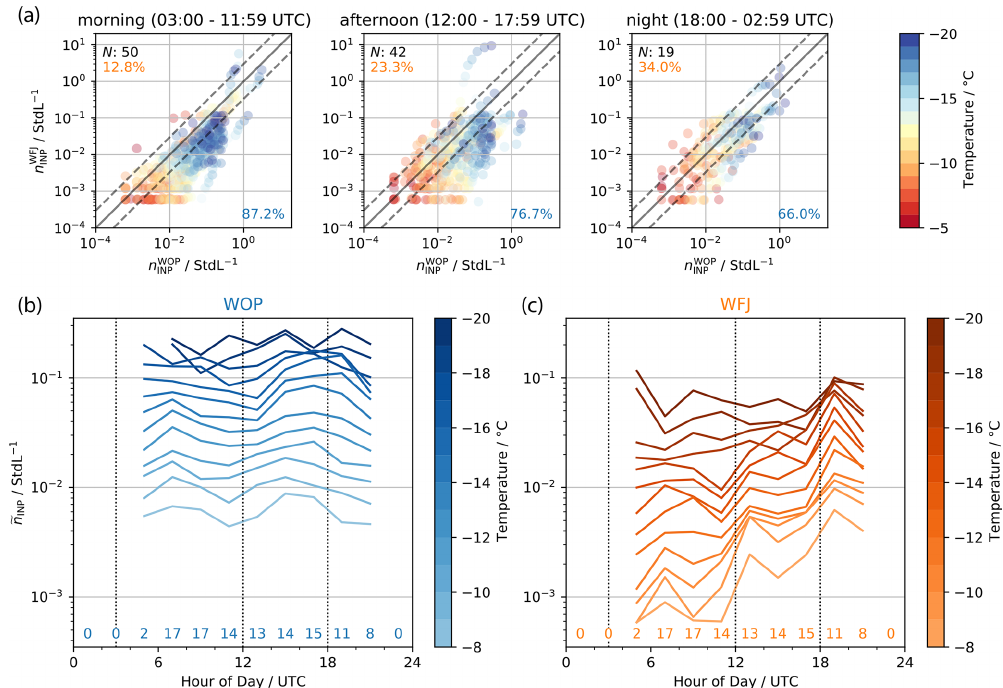
Figure 4. (a) Scatterplots of INP samples taken in parallel on the mountaintop (WFJ) and high valley (WOP) site in the morning, afternoon, and at night. Samples were considered to be in parallel when their sample time differed by less than 30min. The color indicates the activation temperature of a given pair of INP concentrations. The solid line represents the 1 : 1 line, whereas the dashed lines indicate an offset by a factor of 3. The number of available samples ( N ) per period is indicated on the upper left. The percentage of observed INP concentrations at WFJ exceeding INP concentrations found at WOP and vice versa are given in the upper left and lower right, respectively. (b, c) Time series of median INP concentration (cid:101) n INP at different temperatures (from − 8 to − 20 ◦ C in steps of 1K) for samples taken at WOP (b) and WFJ (c) . The samples were binned in 2h intervals for the median calculations. The number of samples available within each 2h bin is indicated at the bottom of the plot. The dotted vertical lines represent the separation times used for data selection and to calculate median values across INP spectra (see Fig.